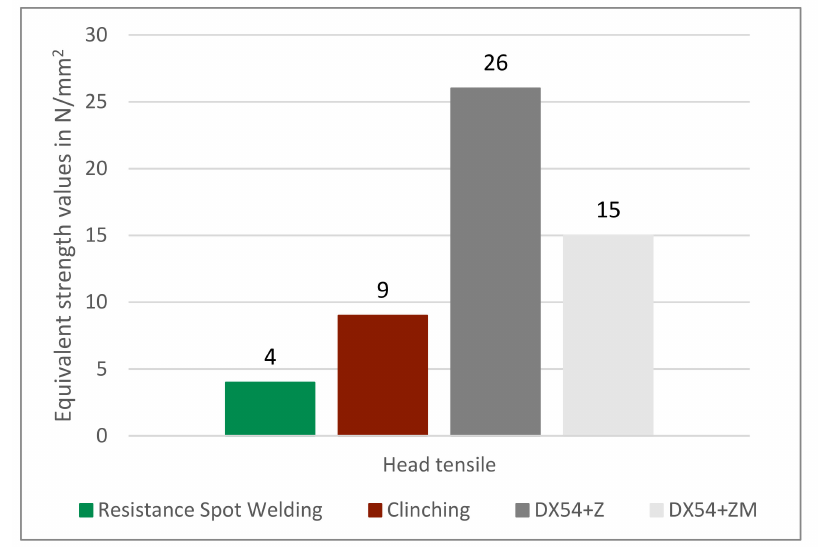
Figure 12. Equivalent strength values for resistance spot welding, clinching, and the shown joining